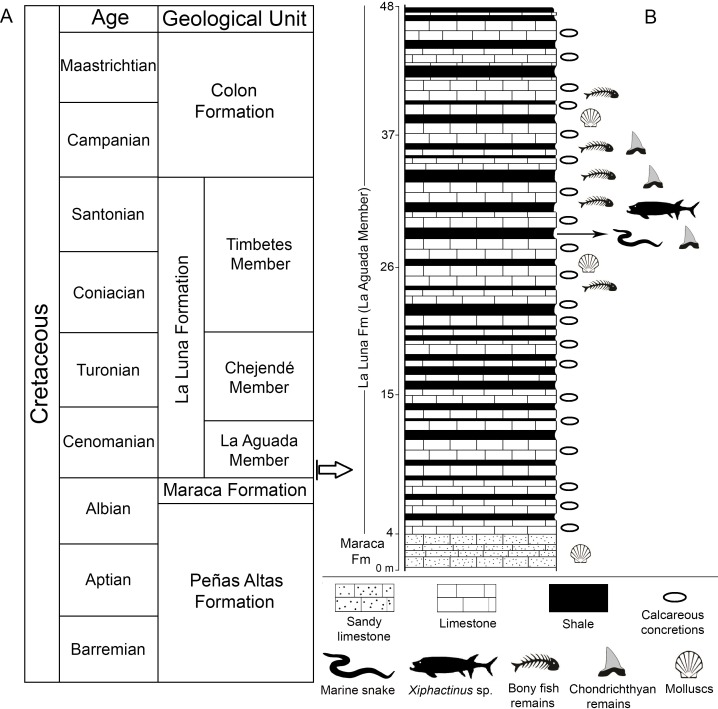
Stratigraphic context.(A) Cretaceous lithostratigraphic units of the Chejendé region, near Monay city, Trujillo State (modified after Renz, 1959 and González de Juana, Iturralde de Arocena & Picard, 1980); (B) Stratigraphic section of the Aguada Member in the Cementos Andinos quarry.